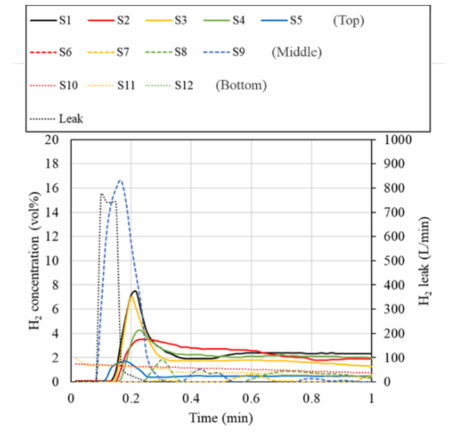
Figure 9. Hydrogen concentration variation by leak (Case 26: hydrogen supply pressure 3 kPa, leak hole 3/8 inch, leak amount 750 L/min, no vent opening, no fan, and shutoff valve works at 1